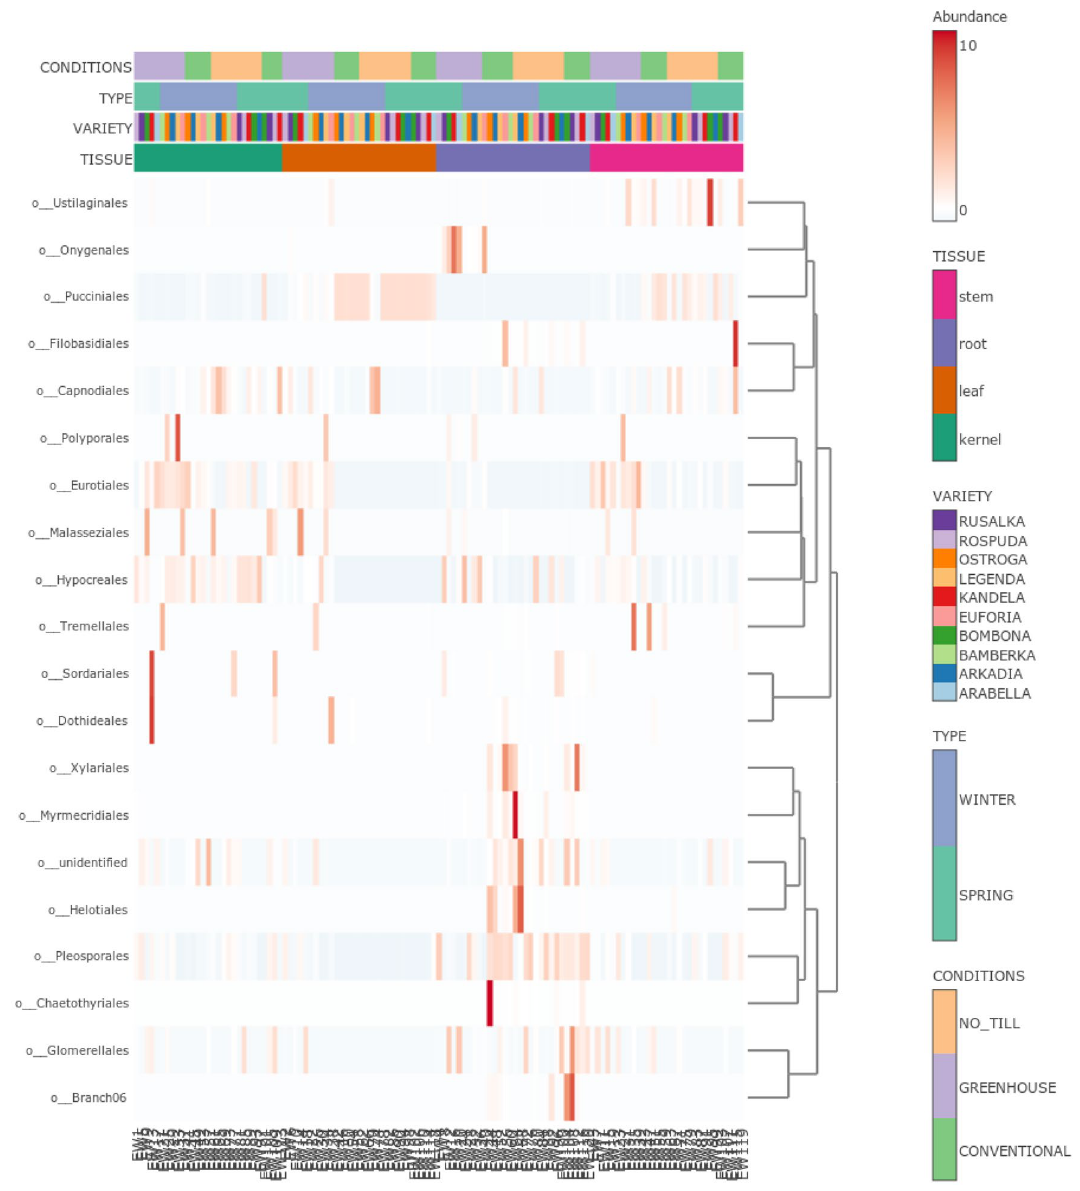
Figure 7. Heat map presenting the abundance of endogenous fungi of wheat in diverse conditions, tissue types, forms, and cultivars on order level. The color gradient (white to red) represents the fungal abundance level in each